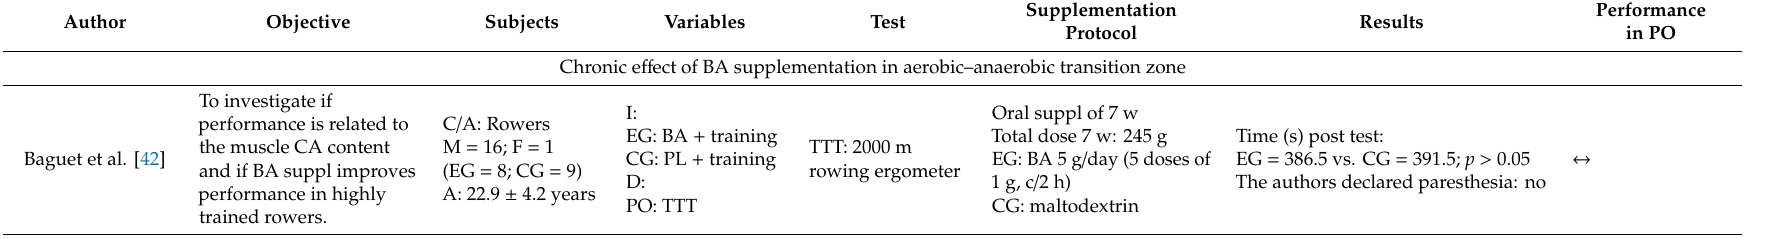
Table 1. Characteristics of the studies that connect BA supplementation with physical performance in aerobic–anaerobic transition